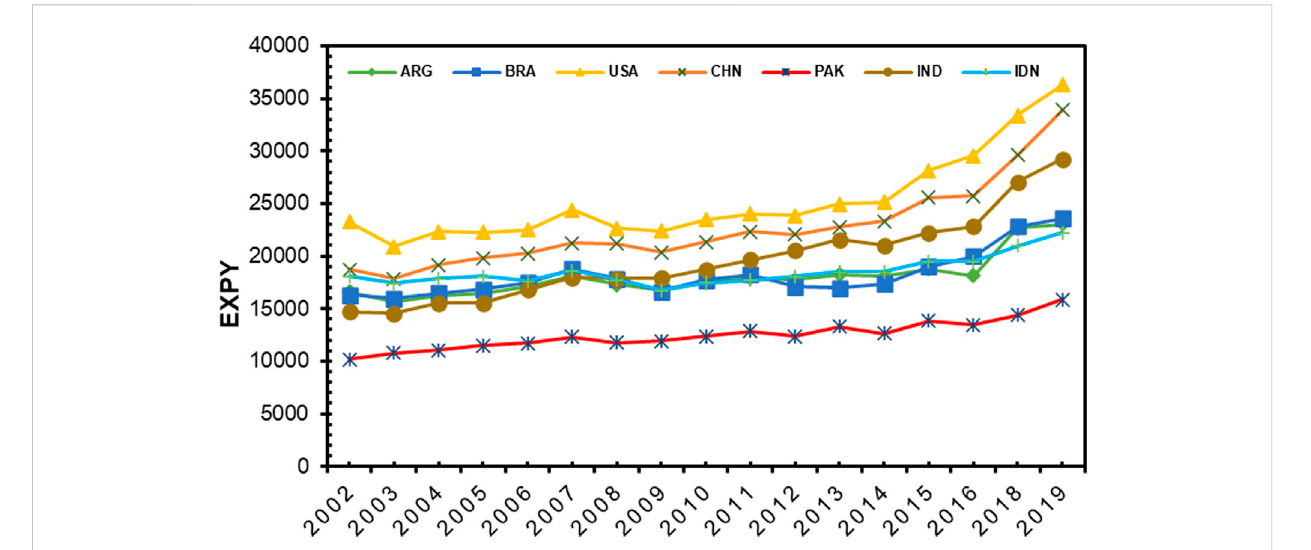
FIGURE 3 EXPY trend of considered countries from 2002 to